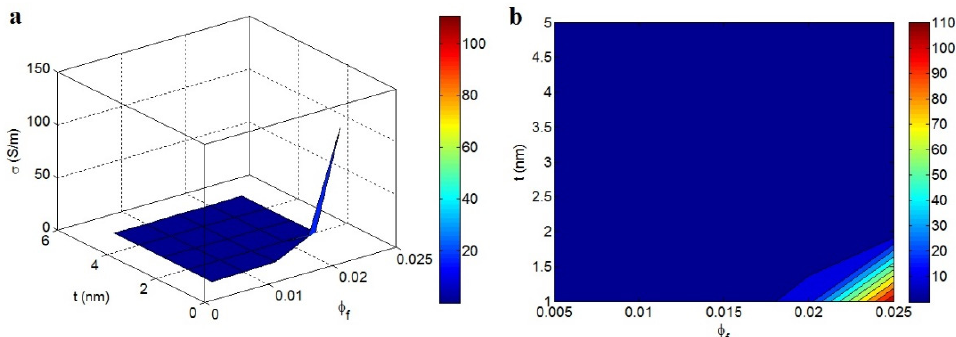
φ Figure 3. Conductivity when φ f and t are substituted into Equation (14): ( a ) three-dimensional (3D) Figure 3. Conductivity when f and t are substituted into Equation (14): ( a ) three-dimensional and ( b ) two-dimensional (2D) (3D) and ( b ) two-dimensional (2D) illustrations.